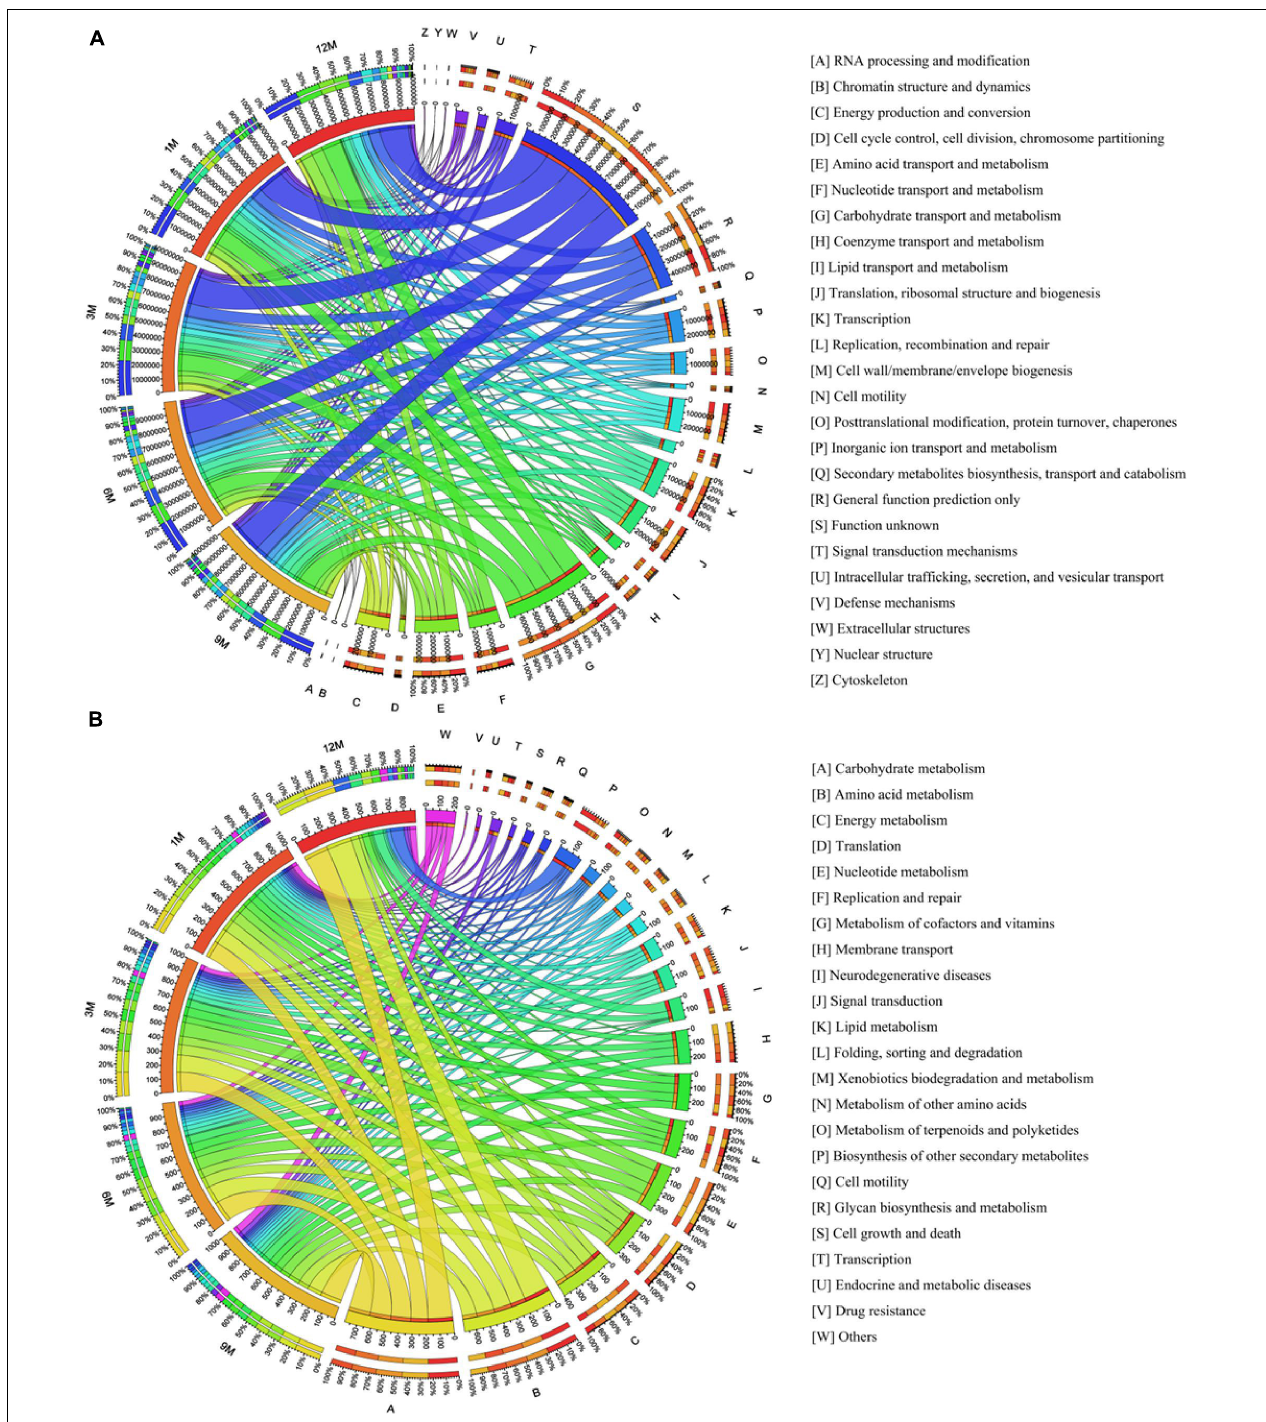
FIGURE 1 | Functional annotation analysis of traditional fish sauce samples at different fermentation stages using eggNOG (A) and KEGG (B) databases, based on metagenomics.